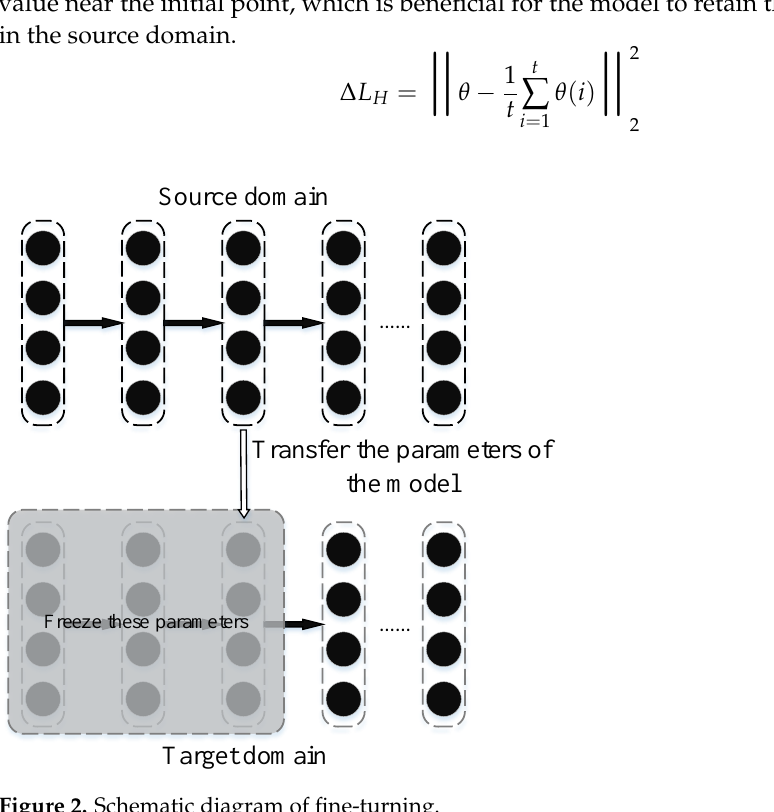
Figure 2. Schematic diagram of fine-turning.